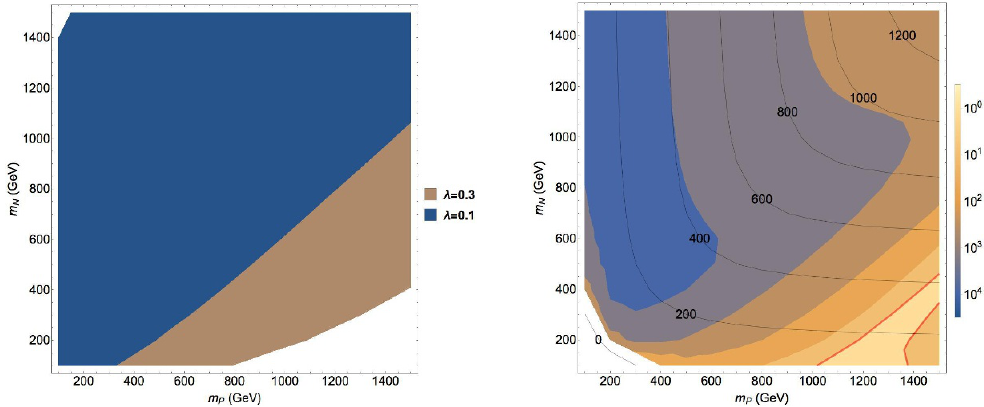
Figure 4 . Two examples of how a thermal 1 relic density with (cid:11) x = 10 (cid:11) can be consistent with the current LUX bounds on spin-independent dark matter scattering [99]. The plot on the left illustrates the small (cid:21) scenario, in which (cid:15) ! 0, the lighter 1 state is very singlet-like with suppressed mixing with the doublet. The unshaded regions at the lower right for (cid:21) = 0 : 1 ; 0 : 3 where the 1 state is mostly singlet are allowed by current bounds. The right panel illustrates the scenario where the contributions to nucleon scattering from the dark photon and the Z boson cancel against each other. This plot shows contours of ((cid:10) 1 = (cid:10) DM ) (cid:27) SI =(cid:27) LUX for (cid:21) = 1, (cid:15) = 10 (cid:0) 4 , and m x = 10 GeV. The allowed region between the solid red